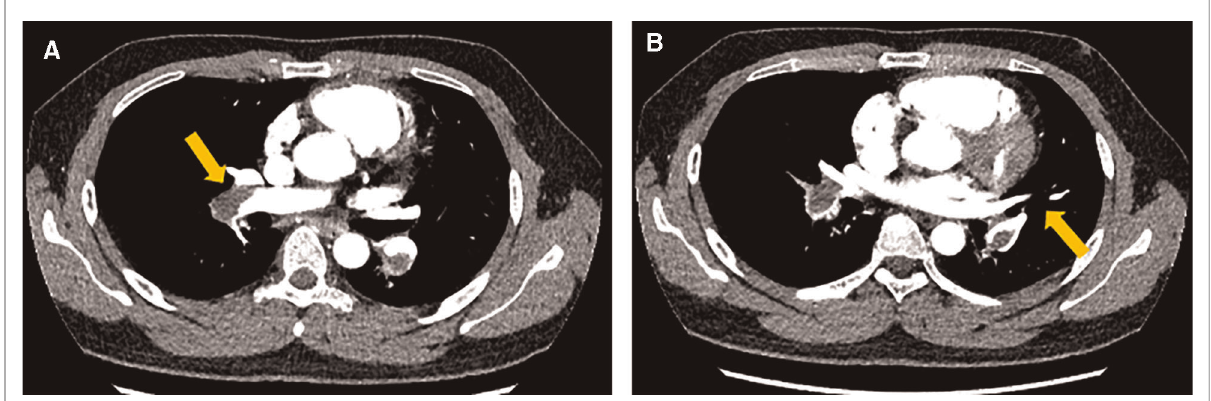
FIGURE 2 The computed tomography pulmonary angiogram (CTPA) presented extensive emboli and signs of bilateral pulmonary artery stenosis and fi lling defects, which were indicated by the arrows both in image A and B .